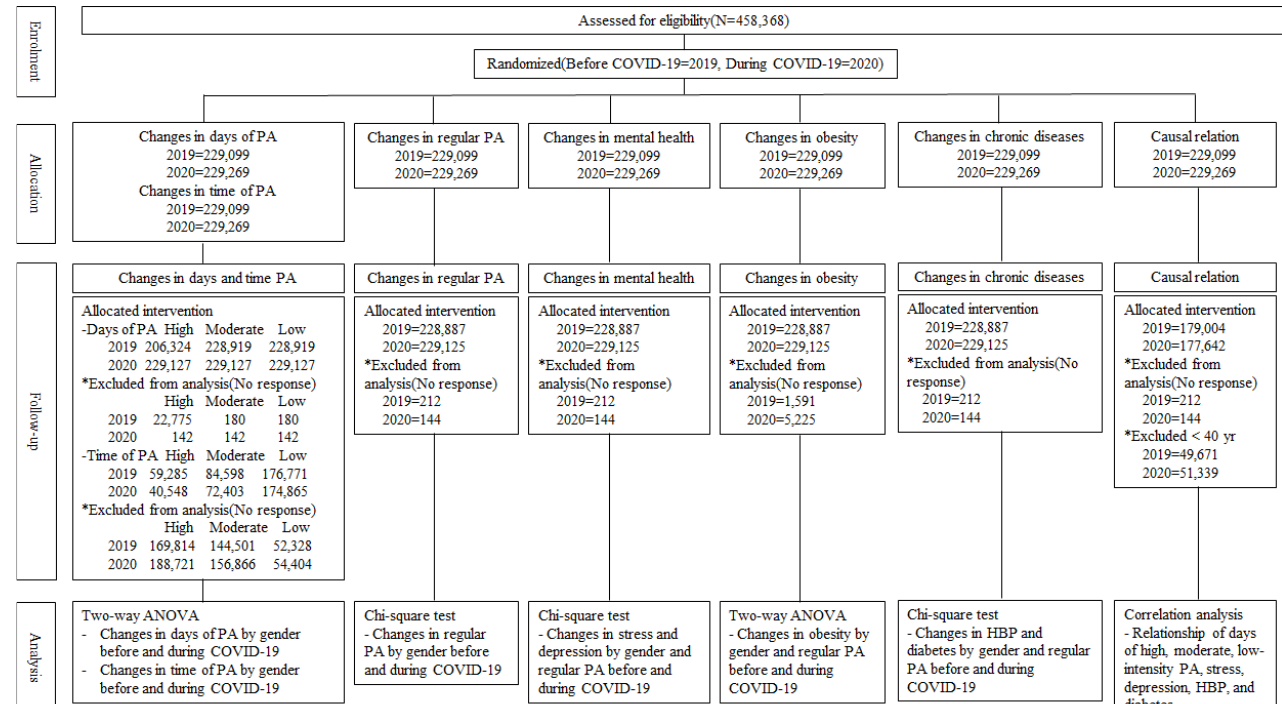
Figure 1. Flow diagram of data analysis.